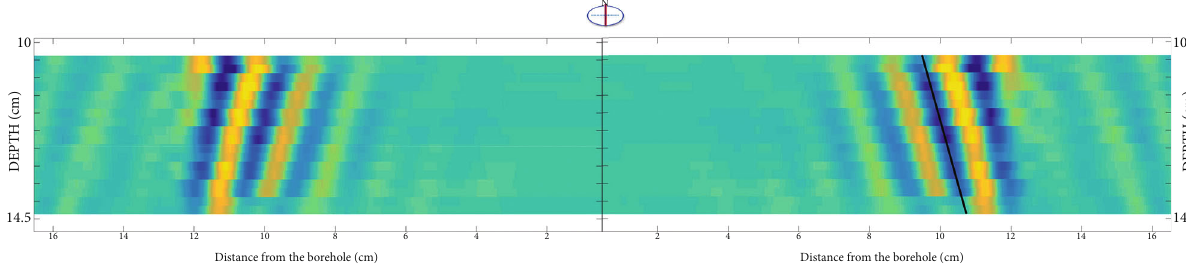
Figure 4: Migration imaging of north to south pro fi